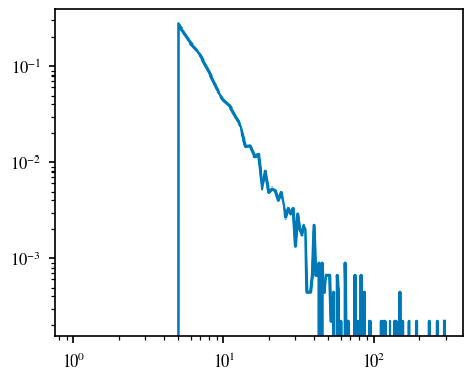
Figure 3. Degree distribution in the constructed BA network.